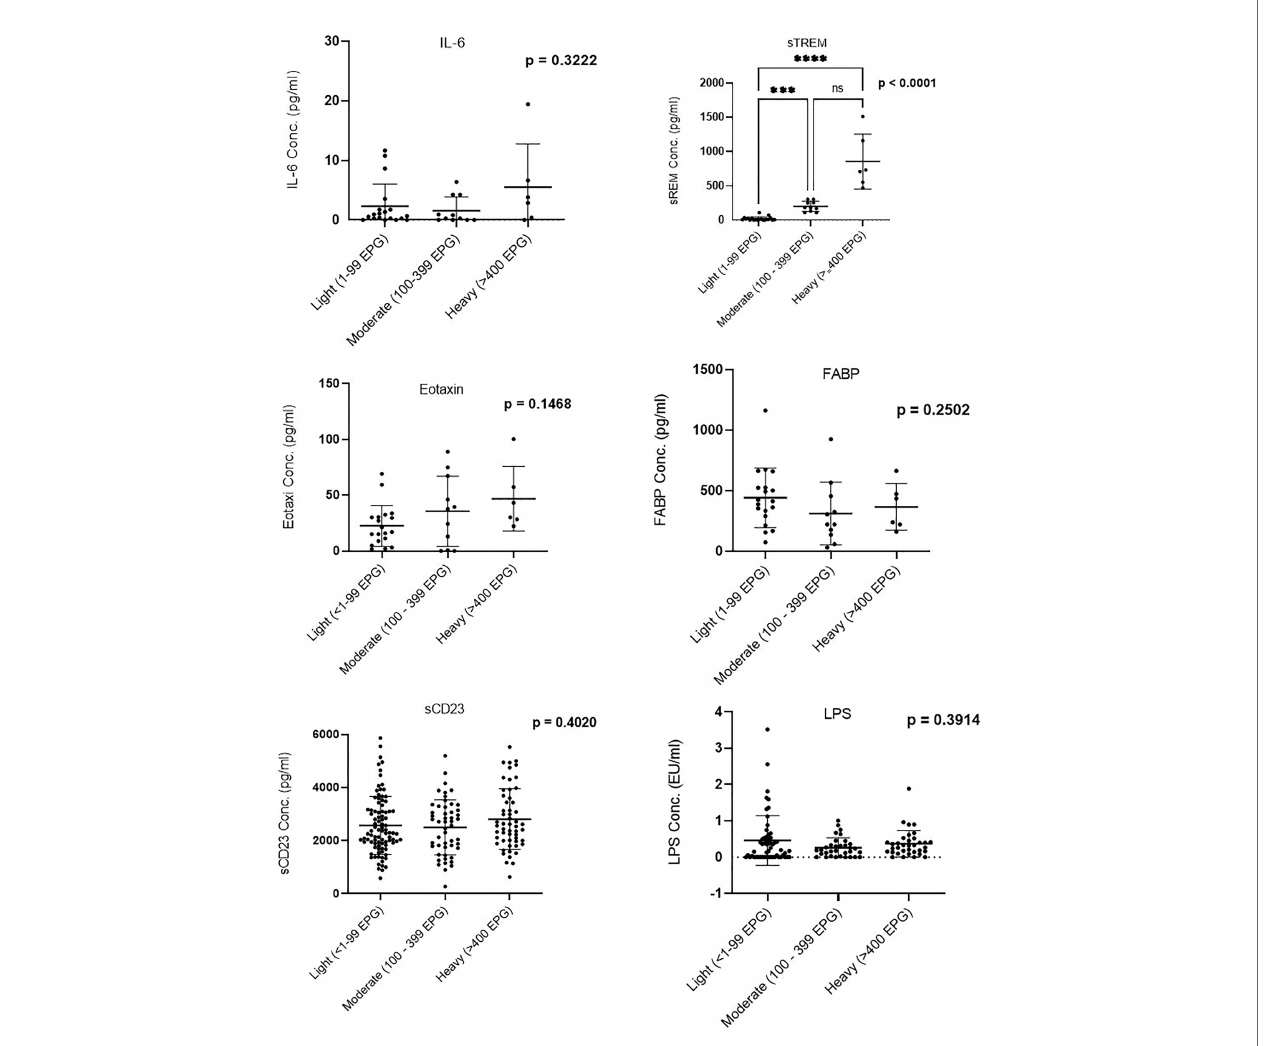
FIGURE 1 | Comparison of biomarker plasma concentration in infection groups. Groups were categorized based on the egg counts into low (1 – 99 EPG), moderate (100 – 399 EPG), and heavy ( ≥ 400 EPG). EPG, eggs per gram. *** (Moderatly signi fi cant, p < 0.0008); **** (Highly signi fi cant level p<00001). ns, not signi fi